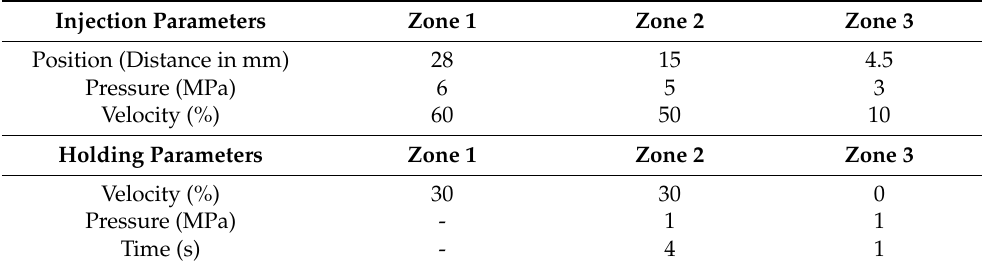
Table 4. Injection parameters used here to mold the specimens according to ASTM D638 standard.